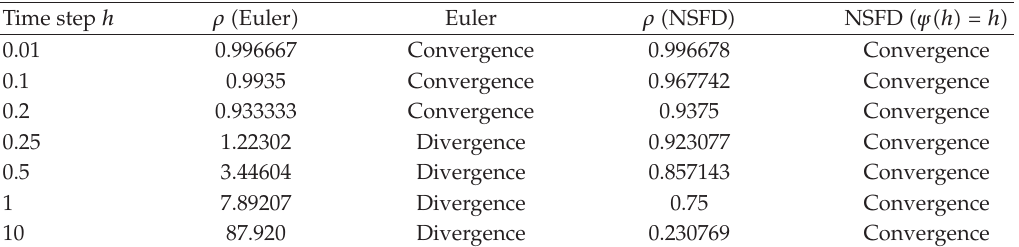
Figure 2: Profiles of subpopulations N (cid:3) t (cid:6) , L (cid:3) t (cid:6) , S (cid:3) t (cid:6) , O (cid:3) t (cid:6) , D S (cid:3) t (cid:6) , and D O (cid:3) t (cid:6) obtained with the NSFD scheme with ψ (cid:3) h (cid:6) (cid:7) h , h (cid:7) 0 . 2 and initial conditions are N (cid:3) 0 (cid:6) (cid:7) 0 . 999 , L (cid:3) 0 (cid:6) (cid:7) 0 . 001 , S (cid:3) 0 (cid:6) (cid:7) 0 , O (cid:3) 0 (cid:6) (cid:7) 0 , D S (cid:3) 0 (cid:6) (cid:7) 0 , and D O (cid:3) 0 (cid:6) (cid:7) 0. Table 3: Spectral radius for di ff erent time step size h of the Euler and NSFD numerical